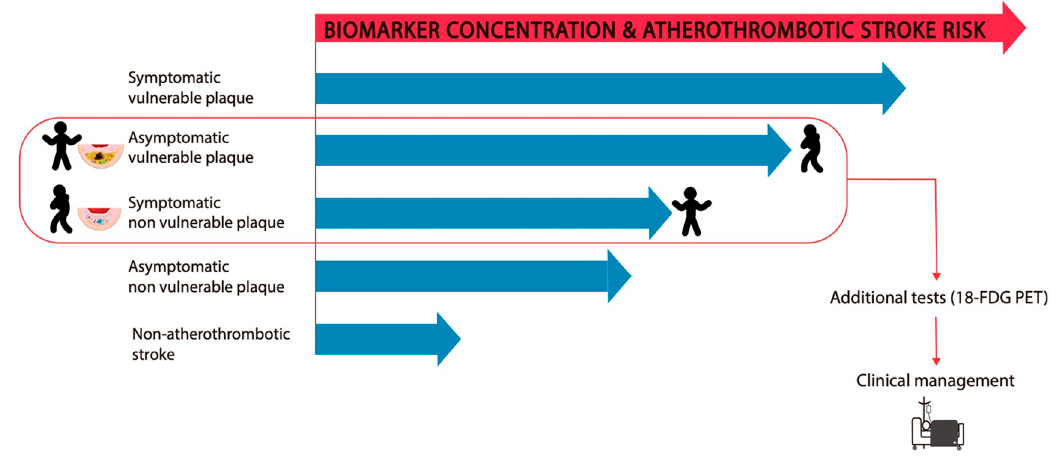
Figure 3. Levels of biomarkers in patients with carotid atherosclerosis and risk of atherothrombotic stroke.